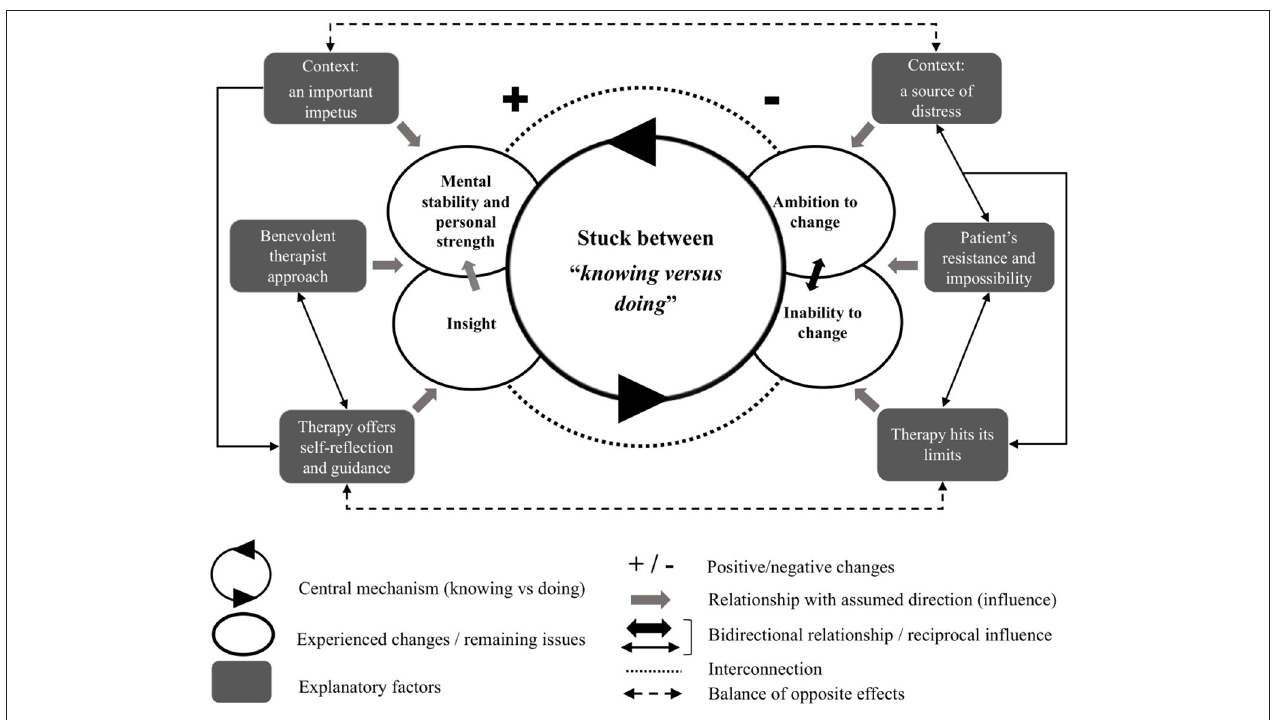
FIGURE 2 | Conceptual model of non-improvement from depressed patients’ perspective.